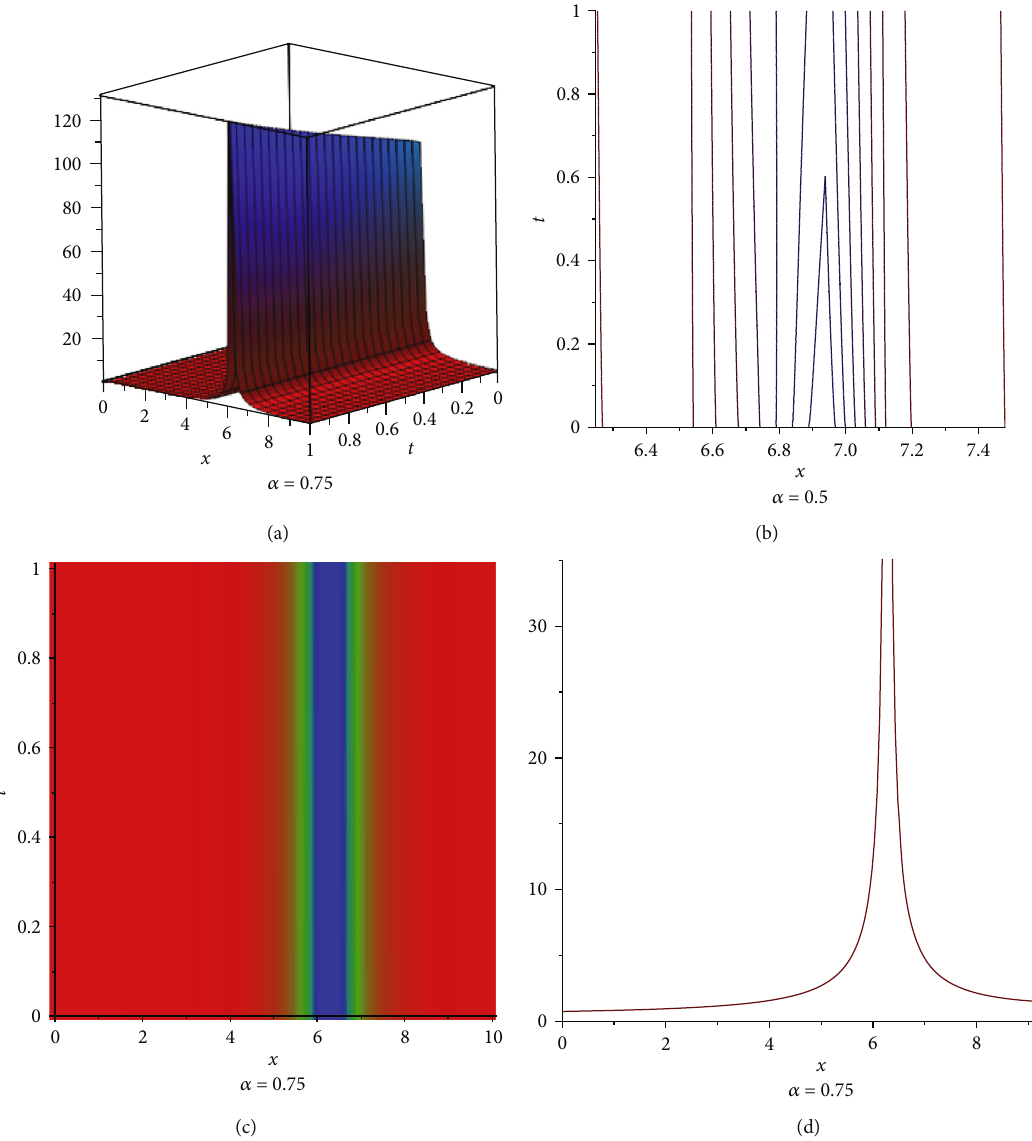
= 0 : 3, δ = δ = d = d = 0 : 1, 1 2 3 1 2